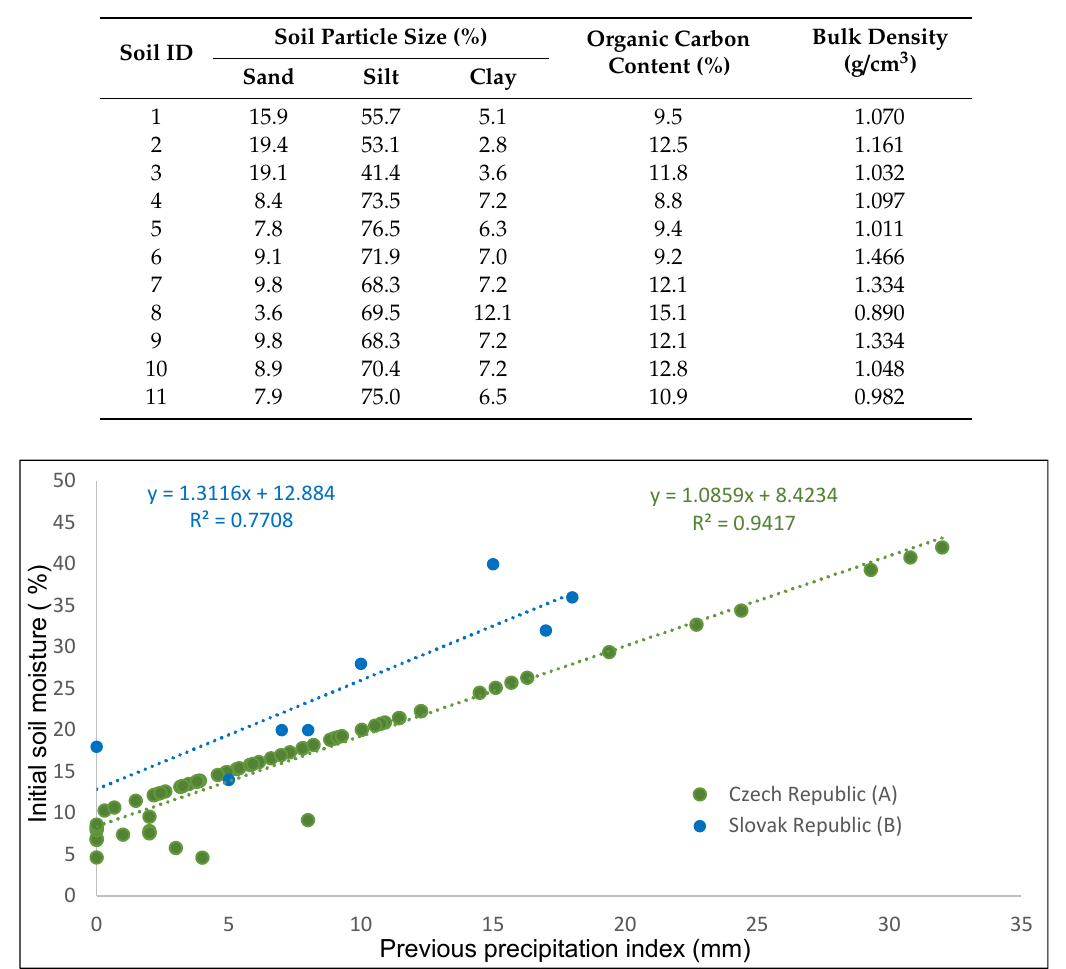
Table 3. The soil characteristics in the study area.